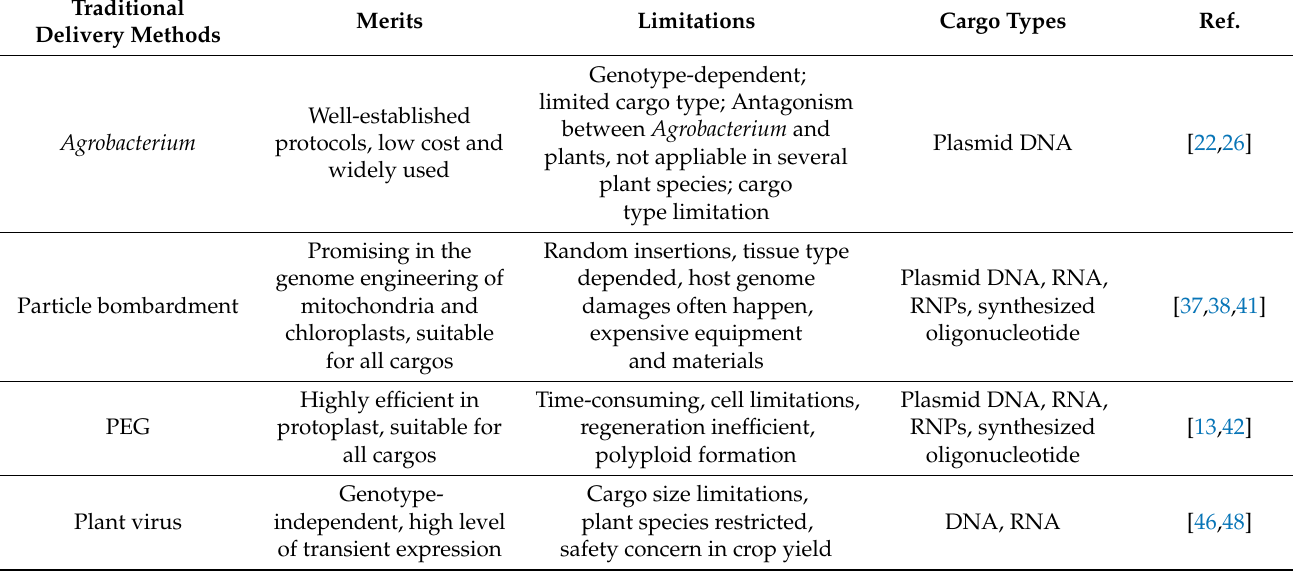
Table 1. The merits and limitations of traditional delivery methods of plants genome